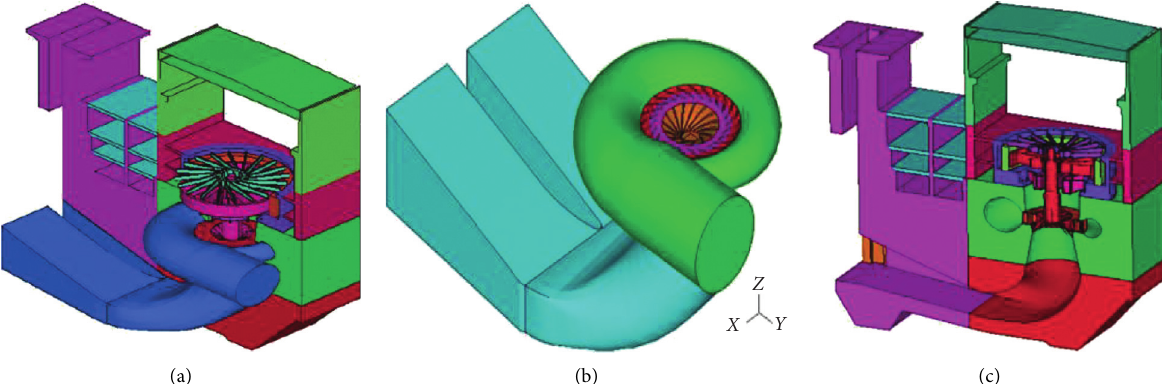
Figure 2: Computational domain (Figure 2 is reproduced from Shuo Wang et al., 2019.). (a) FSI model. (b) Fluid model. (c) Solid model in the axial